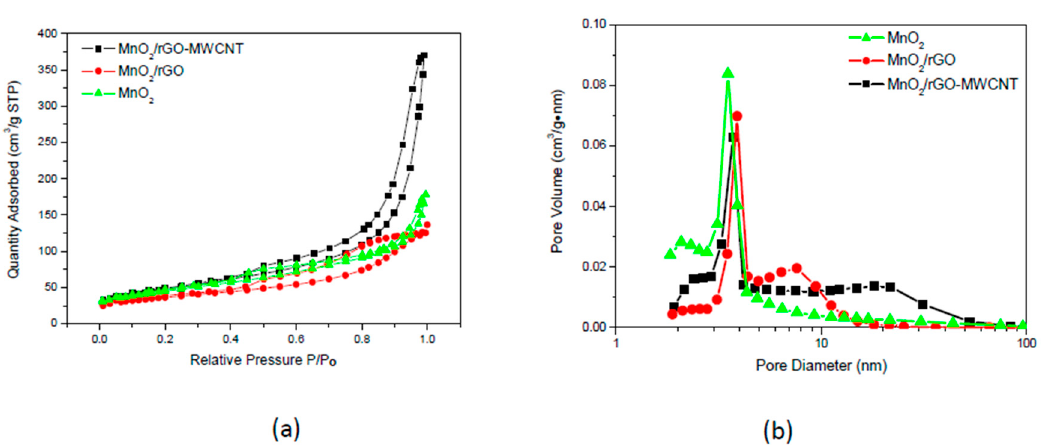
Figure 4. BET specific surface area and pore size distribution analysis for MnO 2 , MnO 2 / rGO and MnO 2 / rGO-MWCNT materials. ( a ) N 2 isotherm adsorption-desorption analysis and ( b ) pore distribution analysis.